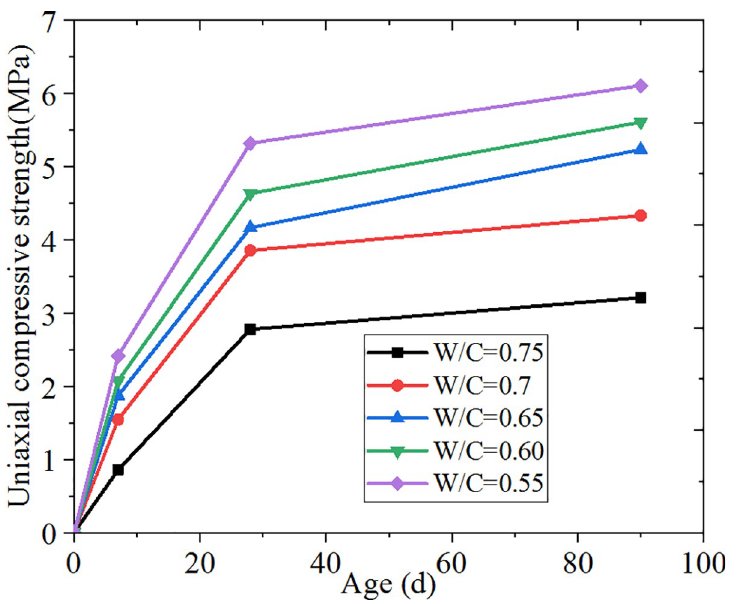
Fig 1. Strength of specimens with different water-to-material ratios at various